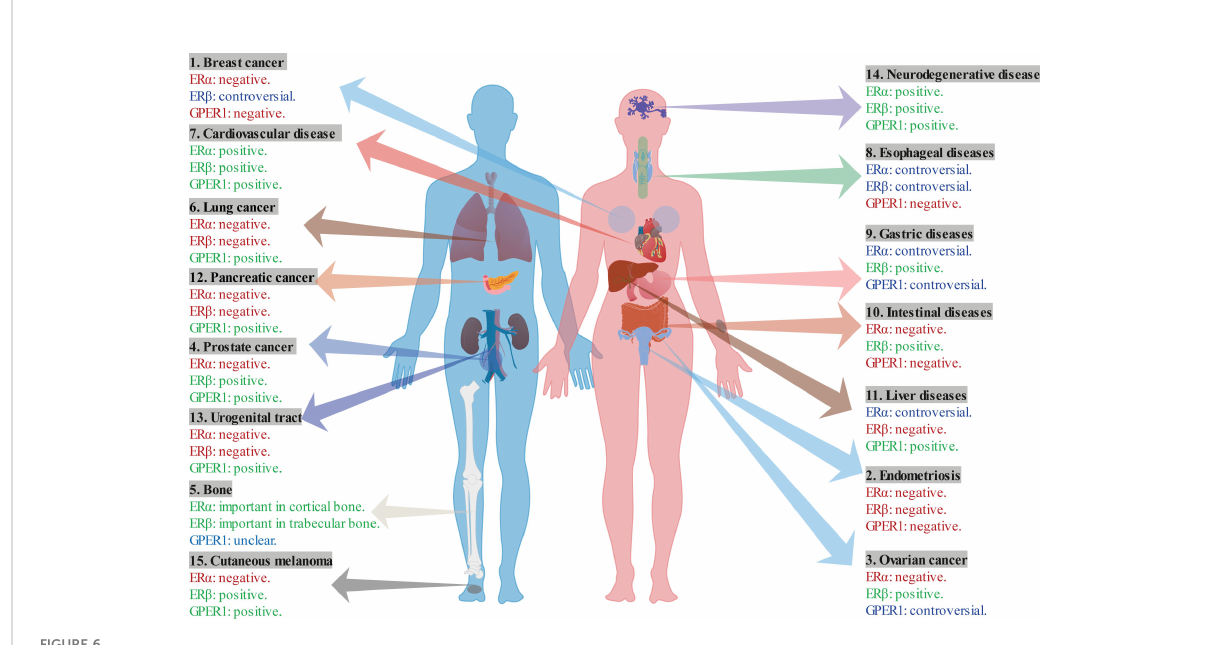
FIGURE 6 The multifaceted role of ERs in various